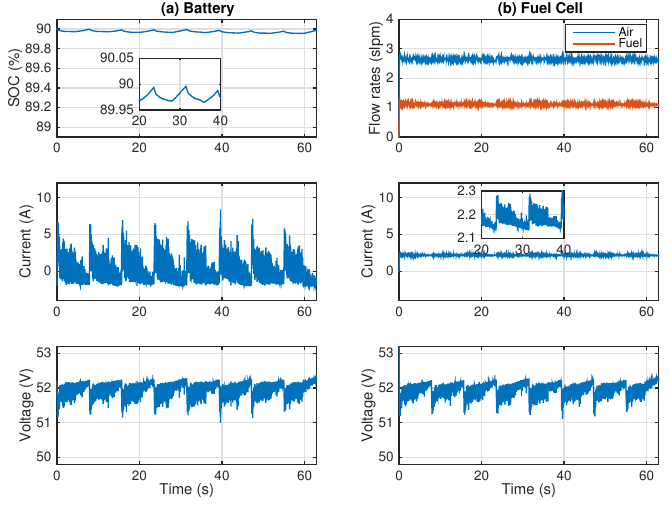
voltage is mainly defined by the Battery, showing small voltage drops that correspond to current peaks drawn by the load. Regarding the FC performance, as the operating point is almost constant, so are the efficiency and flow rate values.